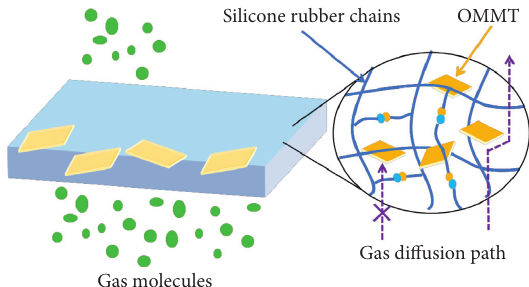
Figure 8: Schematic of gas molecule diffusion in sealing